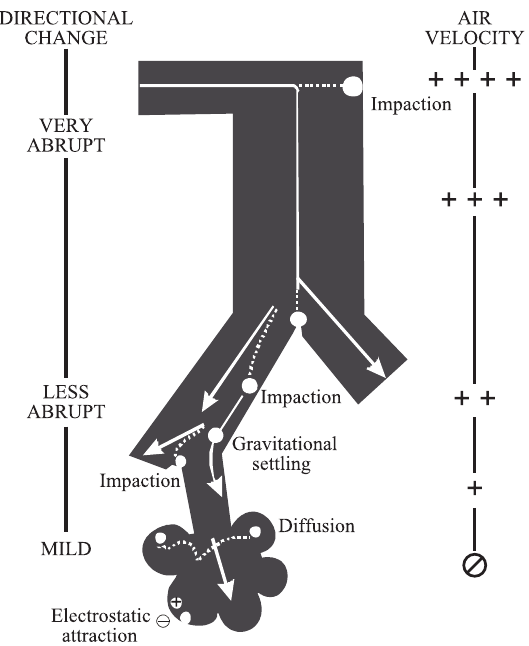
Fig. 1 Schematic view of major mechanisms of particle depo- sition in the respiratory